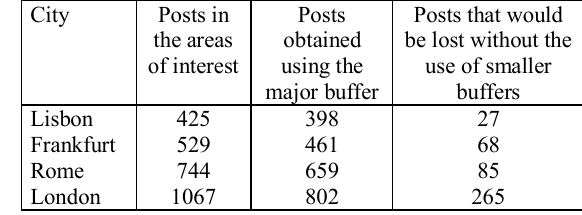
Table 1. Comparison of the number of photographs captured by the outer major buffer (interest area) and its inner